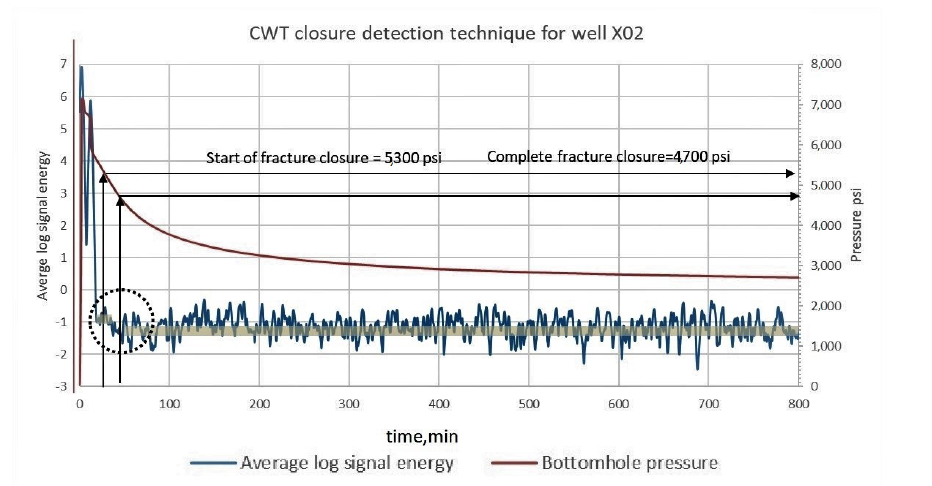
Figure 27. Closure identification using a CWT closure detection technique for well X02.